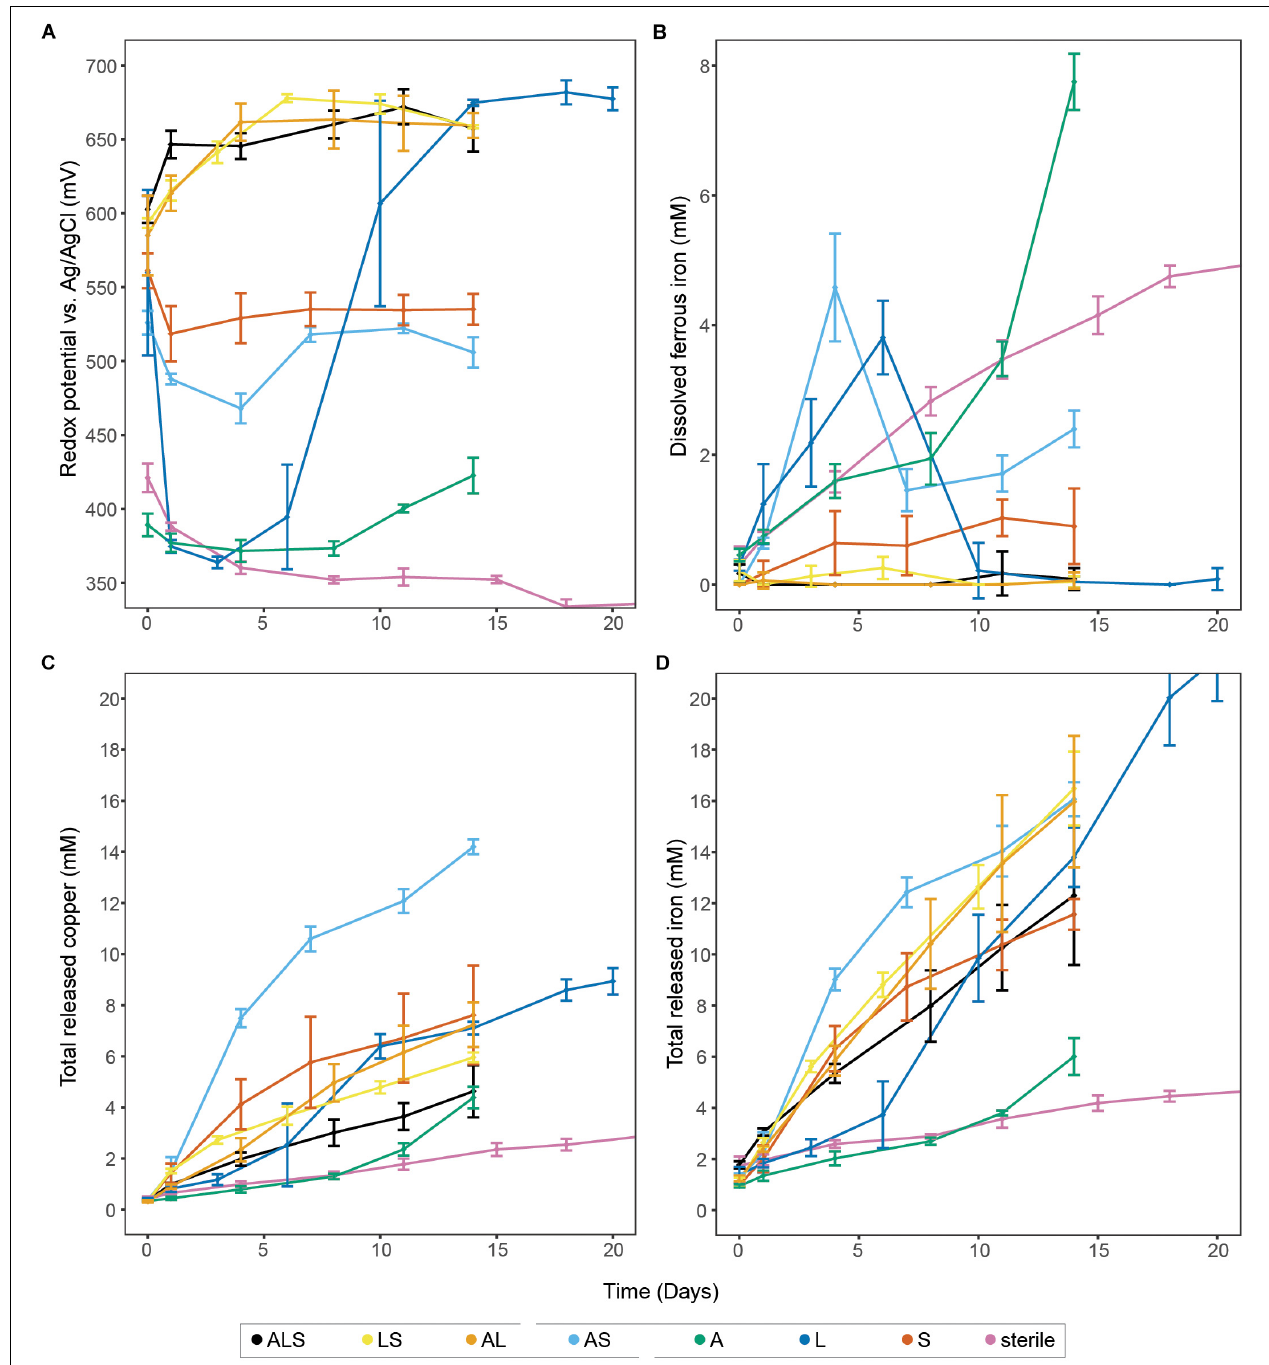
FIGURE 1 | Bioleaching of chalcopyrite concentrate with single species, binary, and tertiary combinations of the three studied model species, plus uninoculated control. The panels show redox potential (A) , dissolved Fe 2 + (B) , and total released copper and iron ( C,D , respectively). Data points represent means ± SD ( n = 4). Abbreviations in the legend denote: A, A. caldus , L; L. ferriphilum ; and S, S. thermosulfidooxidans